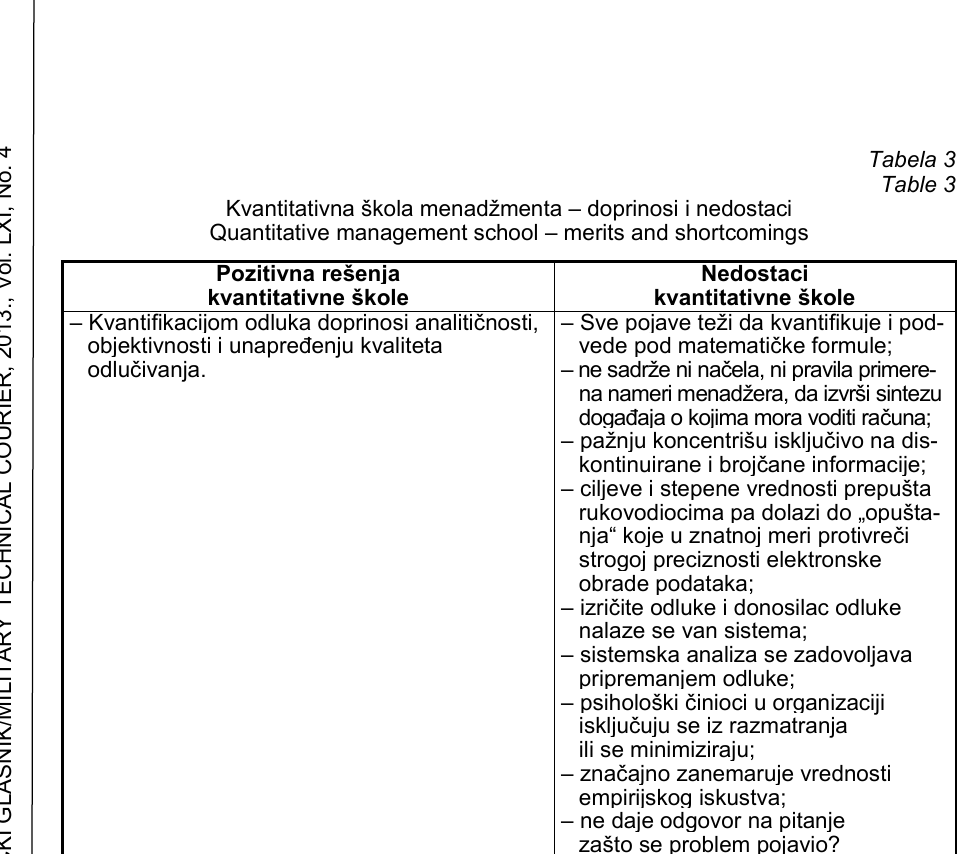
Kvantitativna škola menadžmenta – doprinosi i nedostaci Quantitative management school – merits and shortcomings Pozitivna rešenja kvantitativne škole